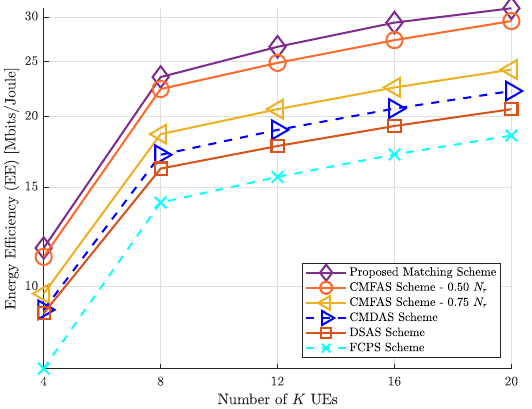
Figure 7. EE versus number of UEs, where M = 80 APs, N Q = 8, ρ = 23 dBm, and N r =